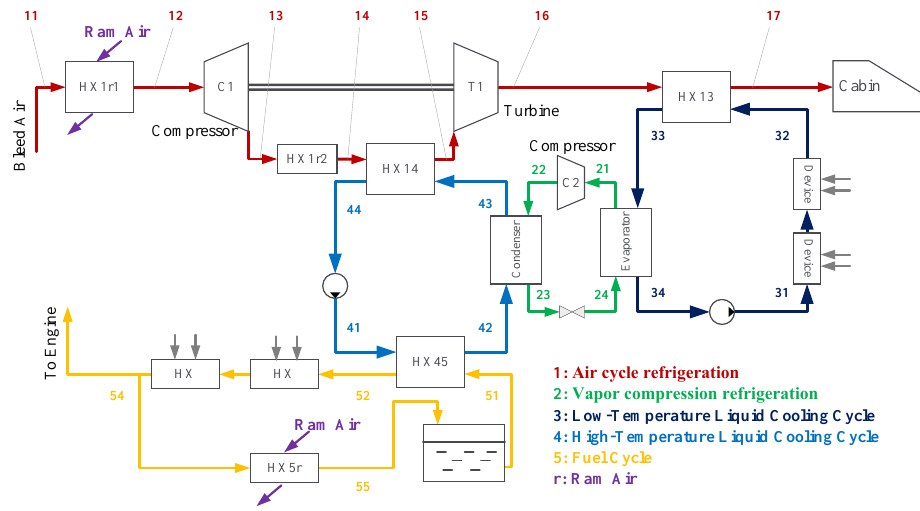
Figure 1. Structure of the integrated thermal management system. These five subsystems are coupled with each other through heat exchangers to achieve the goal of thermal management. The functions of each subsystem are detailed